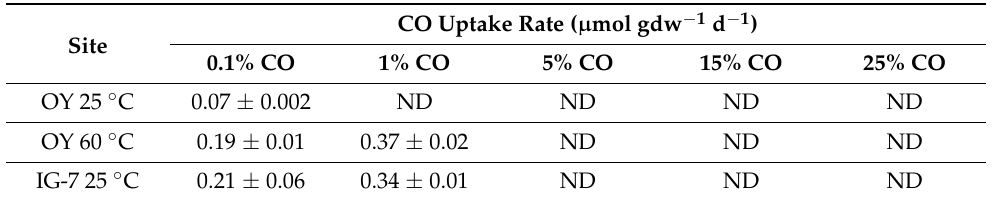
Table 2. CO uptake rates ( µ mol gdw − 1 d − 1 ) at sites OY (25 ◦ C and 60 ◦ C) and IG-7 (25 ◦ C) for CO concentrations of 0.1%, 1%, 5%, 15%, and